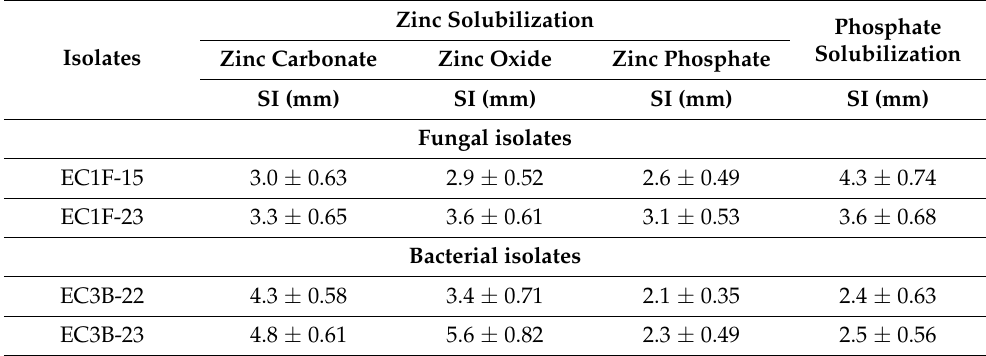
Table 1. Zinc salts and phosphate solubilization by endophytes.